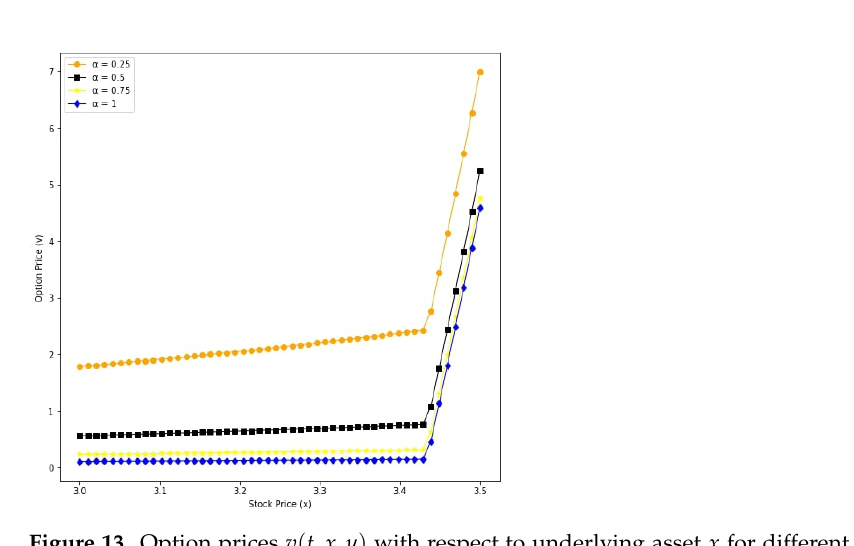
Figure 12. Option prices v ( t , x , y ) with respect to underlying asset y for different α values : v for x = 2.3024 and ρ = 1.